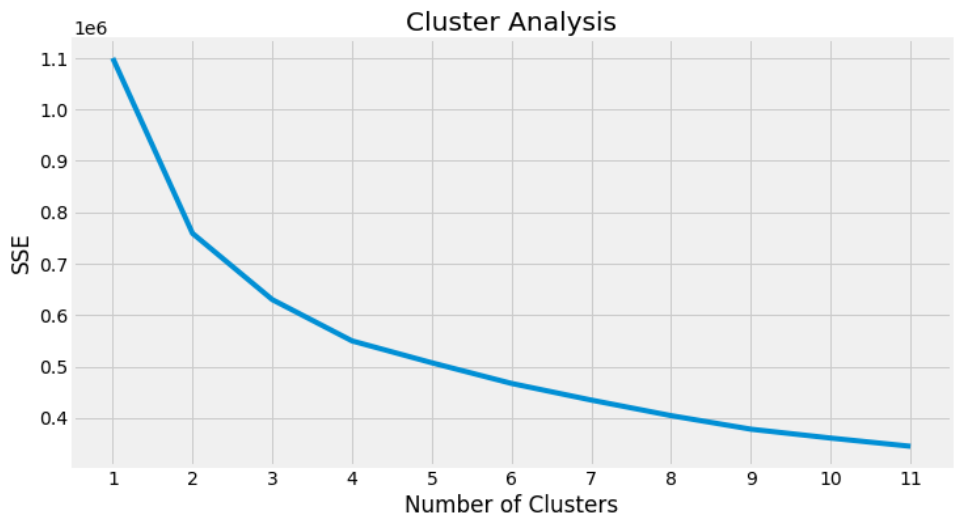
Figure 7. SSE Analysis to determine nº of clusters.